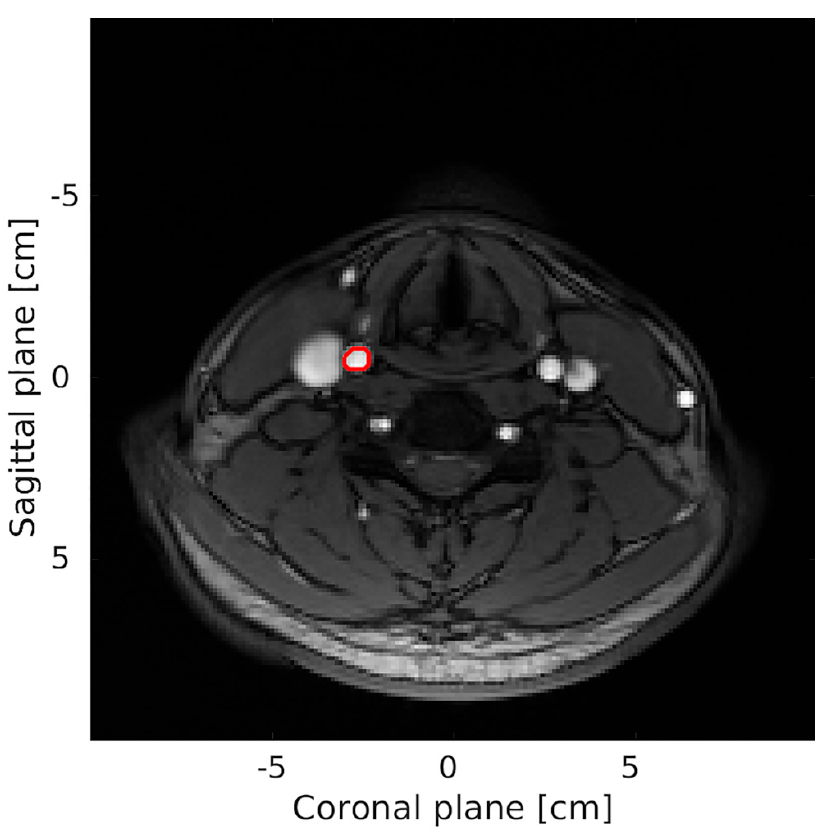
Figure 2. Transverse 2D time-of-flight sequence of the neck obtained with MRA. An example of volume flow of the right CCA was found within the region of interest ( marked red ). The MRA volume flow was found from a corresponding through-plane phase contrast MRA sequence (not shown).